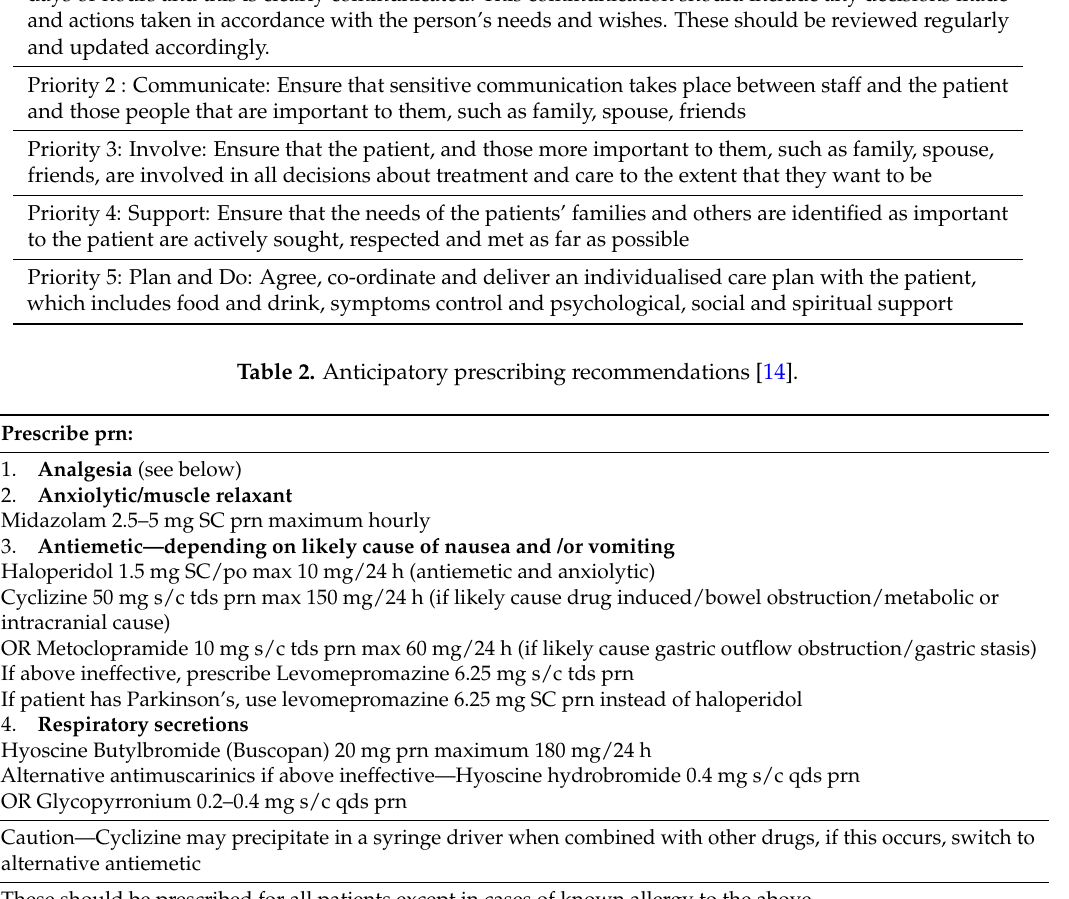
Table 1. Priorities of care for the dying person.